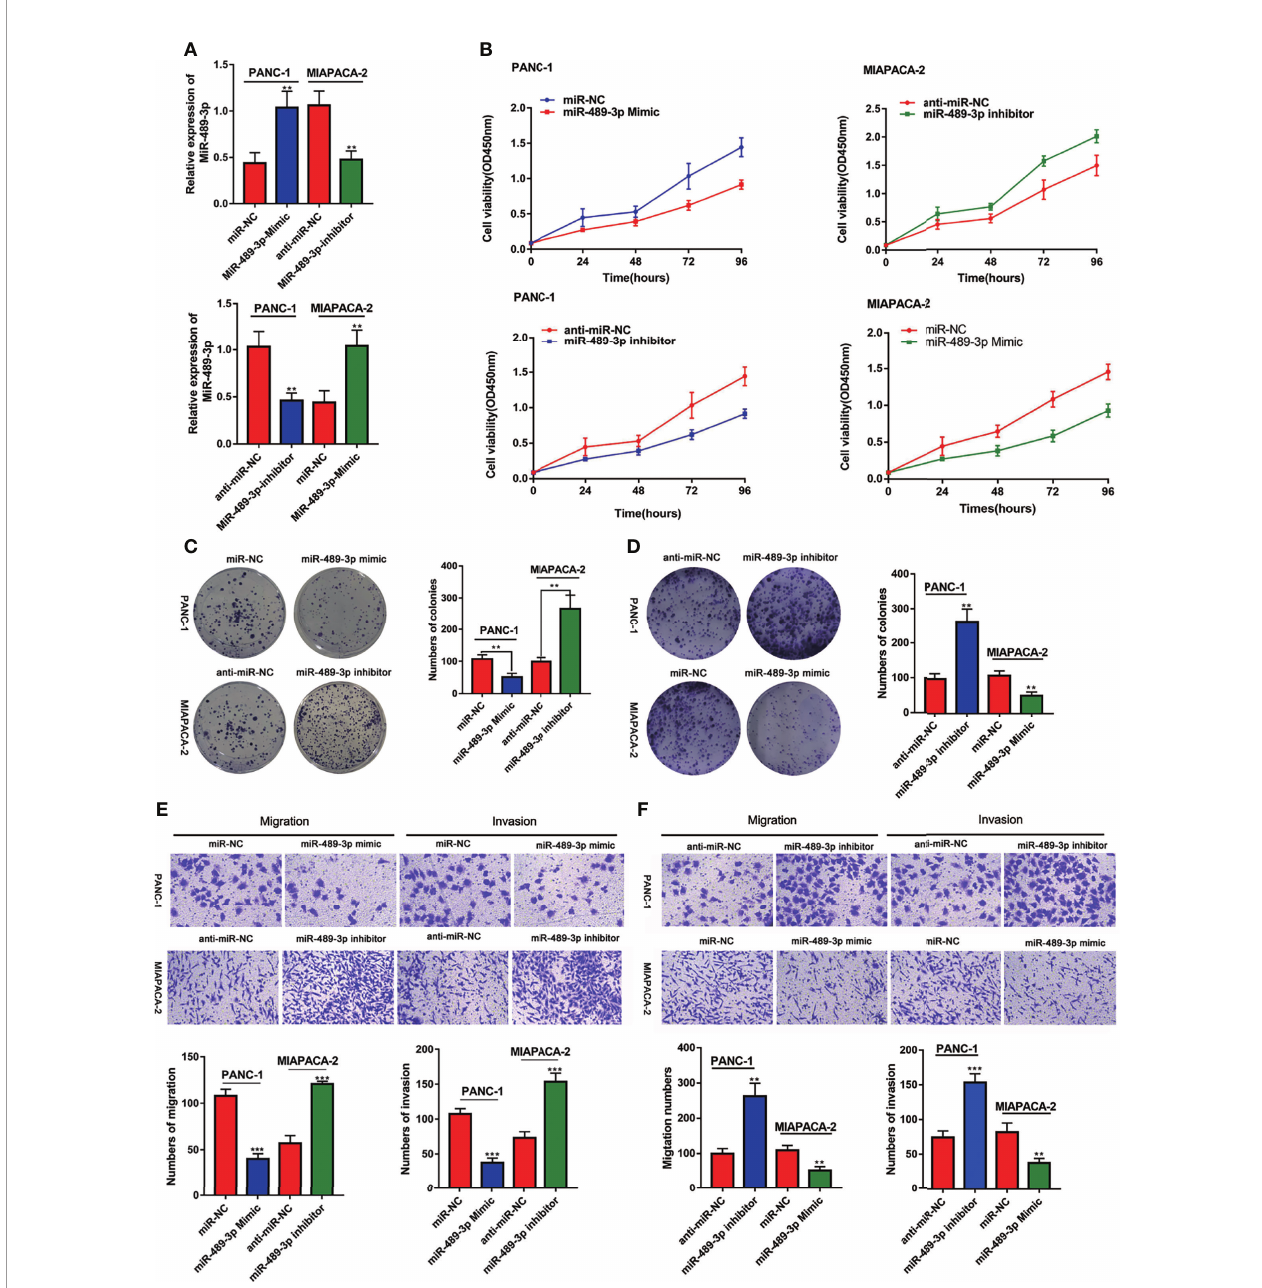
FIGURE 2 | MiR-489-3p inhibits proliferation and invasion of pancreatic cancer. (A) qRT-PCR showed the relative expression of miR-489-3p after transfection of miR-489-3p mimic and inhibitor in PC cells. (B – D) CCK8 and plate cloning assays showed the cell proliferation ability of PC cells transfected with miR-489-3p mimics and miR-489-3p inhibitors. (E, F) Transwell migration and invasion assays showed the cell migration and invasion ability of PC cells transfected with miR- 489-3p mimics and inhibitors. (**P < 0.01, ***P <